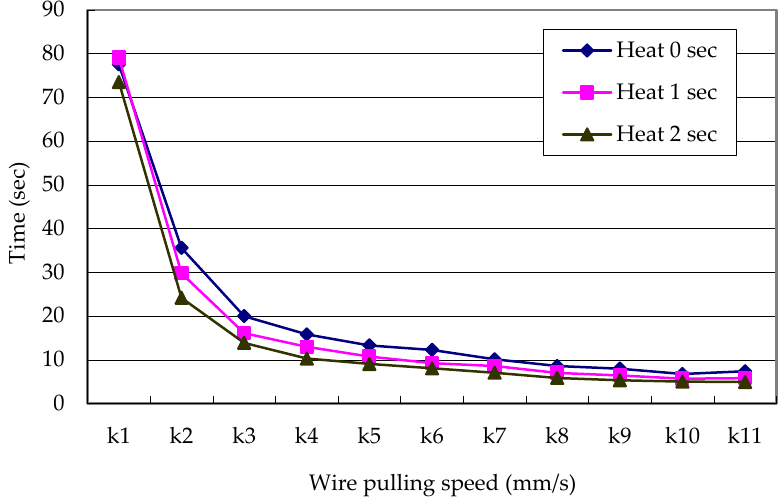
Figure 12. Wire elongating time vs. wire pulling speed for the 0.6 mm wire at different heating periods.